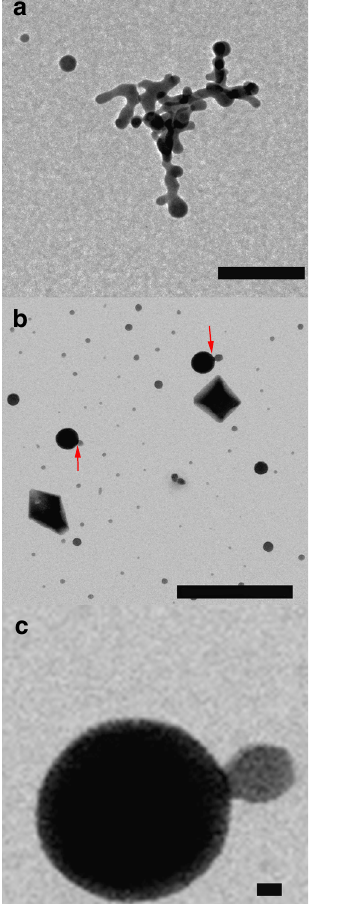
Fig. 5 TEM images of calcium oxalate precipitates formed in titration experiments in the presence of 10 mM citrate at pH 6.2. a TEM image showing particles with dark contrast and well-de fi ned spherical morphology, which are connected with a less dense (lighter contrast) shapeless structure (quenching time: 10,000 s). Scale bar : 500 nm.